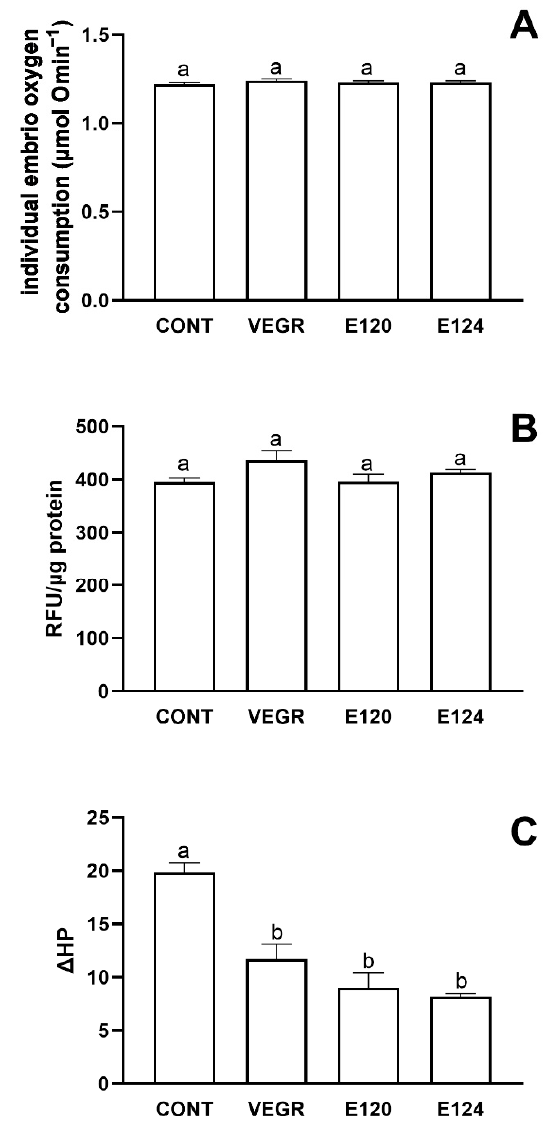
Figure 5. Effect of food dyes (VEGR, E120, and E124) exposition on: ( A ) in vivo routine oxygen con- sumption of Danio rerio larvae; ( B ) ROS levels (expressed as Relative Fluorescent Units, RFU, per µ g protein) of homogenates of D. rerio larvae. Data are expressed as mean ± SEM ( n = 4); and ( C ) in vitro susceptibility to Fe 2+ -ascorbate-induced oxidative stress (measured as the level changes on the lipid- bound hydroperoxide, ∆ HP, expressed as nmol NADPH min − 1 per mg protein) of homogenates of D. rerio larvae. Different letters indicate statistically significant differences among